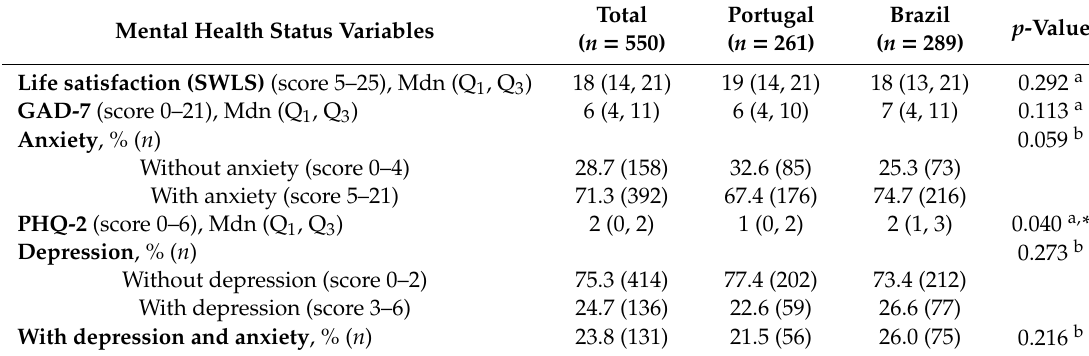
Table 2. Comparison of the mental health status between the two countries of residence (Portugal vs. Brazil; n = 550).